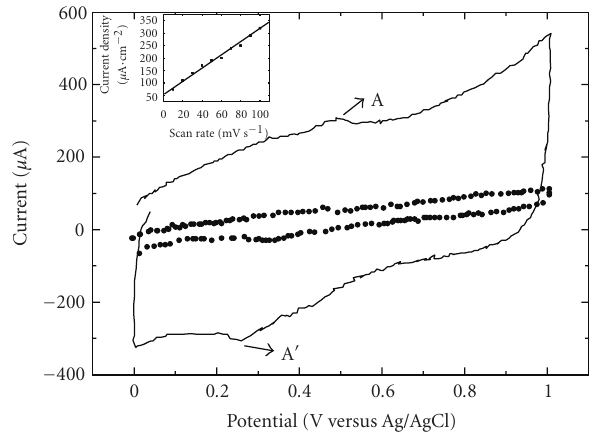
Figure 7: CV i - E curves for NCD/CF electrode in 0.5molL − 1 H 2 SO 4 aqueous solution. Scan rate: 100mVs − 1 (solid line) and 10mVs − 1 (dash